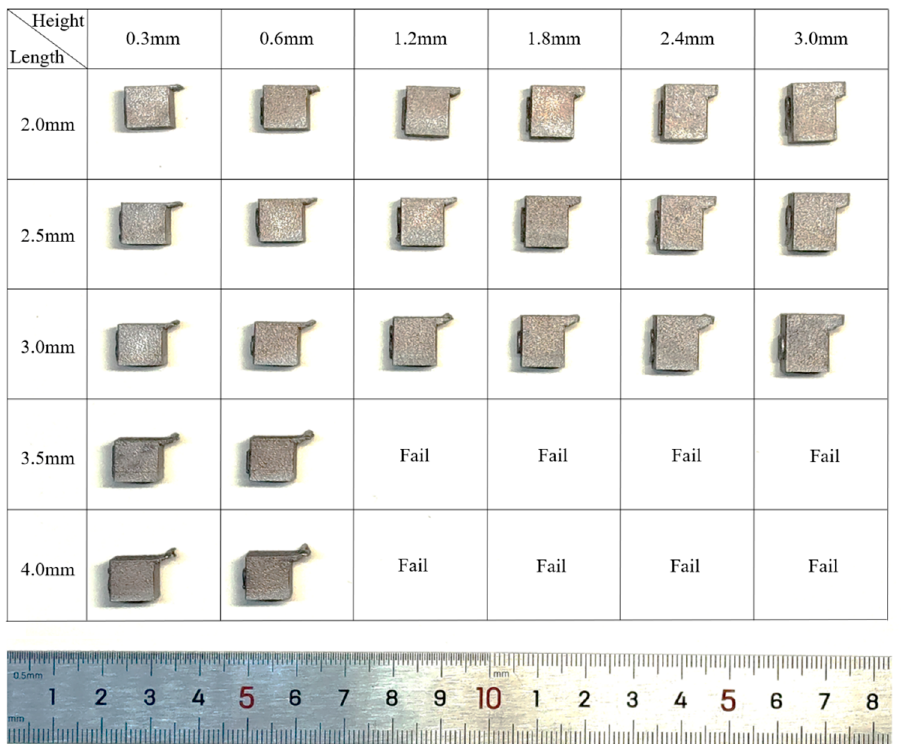
Figure 3. Different heights and lengths of overhang structure specimens.